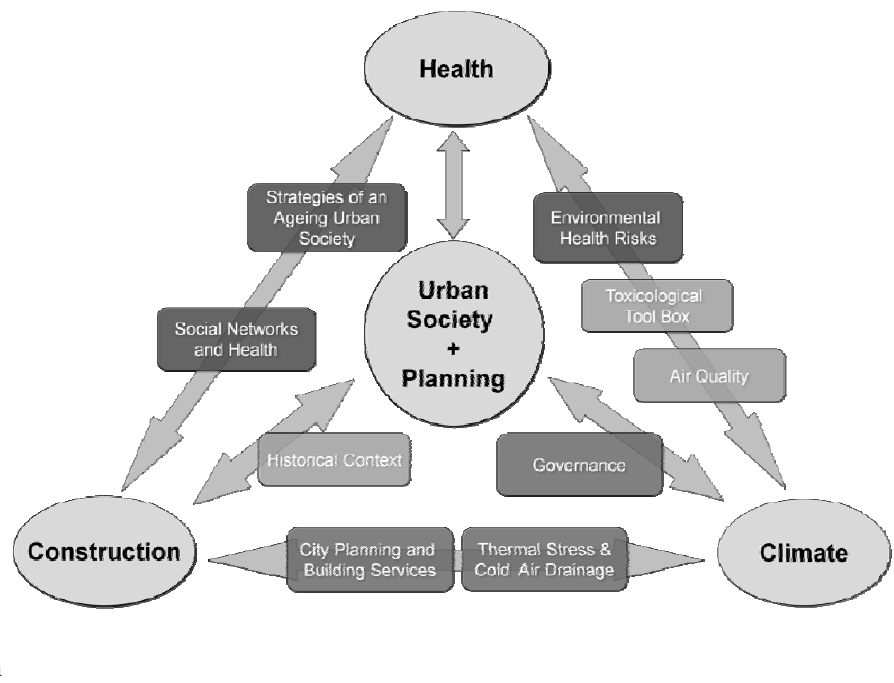
Figure 3. Structure of the CITY2020+ project (modified after